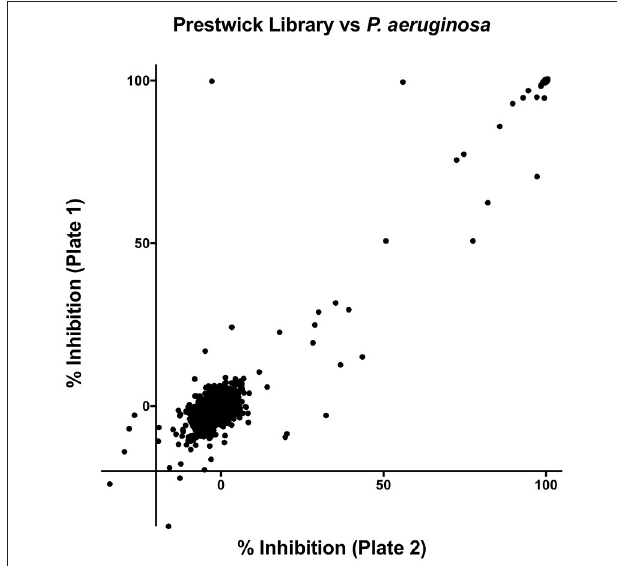
FIGURE 1 | Results of the primary screen, 34 drugs inhibited growth of P. aeruginosa by 50% or